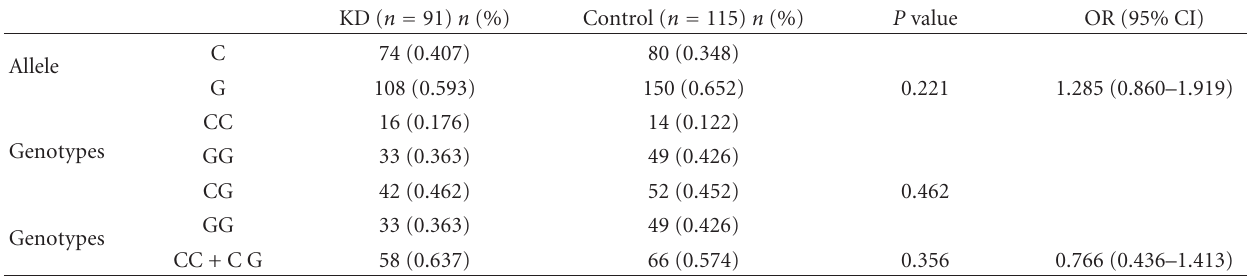
Table 4: RETN ( − 420C > G) genotype and allele frequency in KD patients and controls.